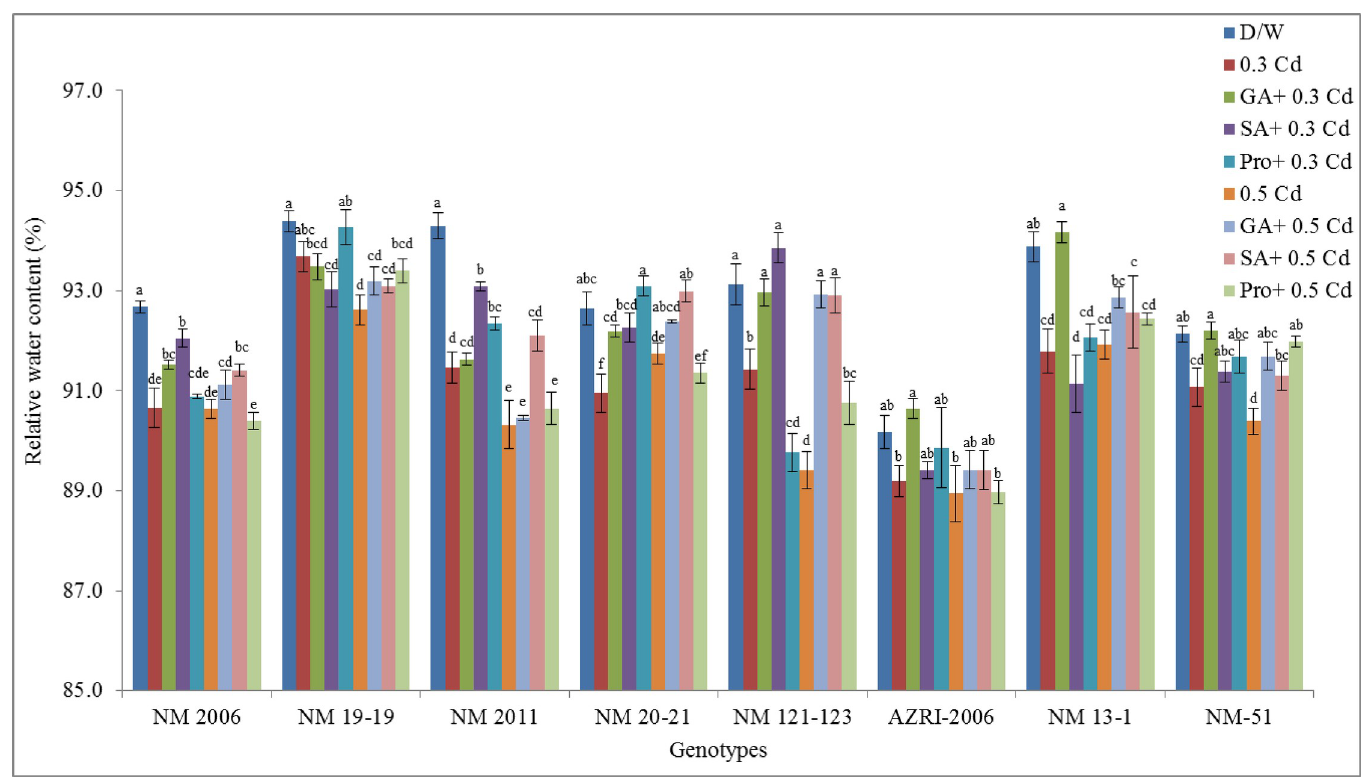
Fig 8. Mean relative water content of mung bean grown under Cd and pretreatments of GA 3 , SA and proline prior to Cd.